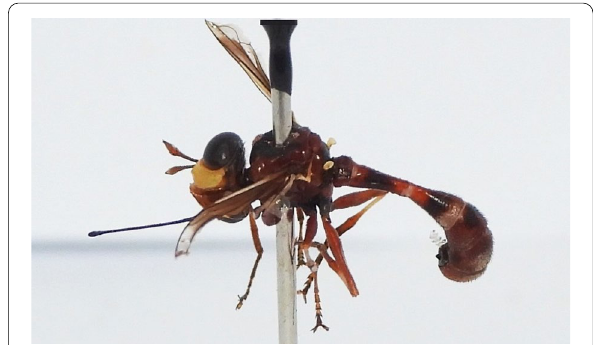
Fig. 2 Physocephala chrysorrhoea (Meigen) male,